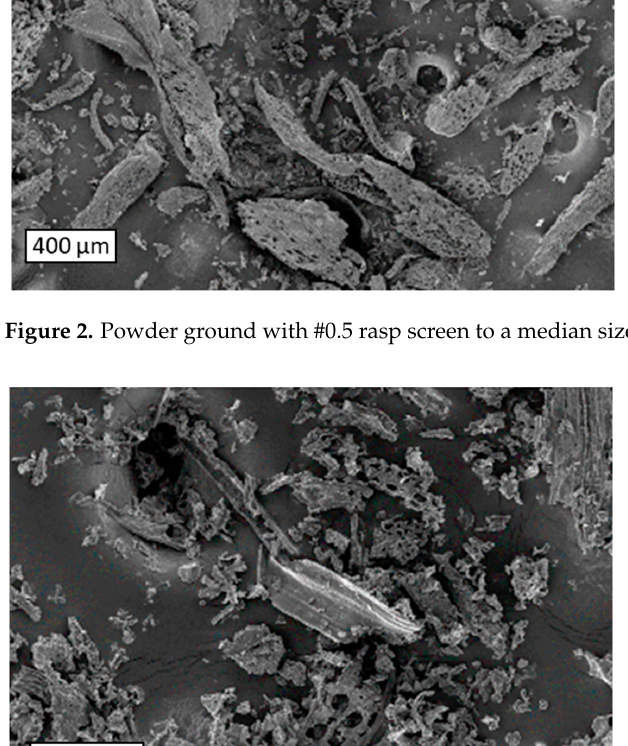
Figure 4. Powder ground with #0.2 rasp screen to a median size of 30 μ m. Magnitude 1000×. 3.2. Particle Size Dependence on Production Rate and Rotor Frequency In pin milling, an increasing production rate increased the particle size. Due to higher mass flow, the energy required for size reduction per mass unit decreased. However, the effect is quite low and, as shown in Figure 5, increasing the impact energy by increasing the rotor frequency has a decisive role in size reduction. The operating range was wide. The product size could vary in the range of 40–400 μ m, primarily by adjusting the rotor frequency.